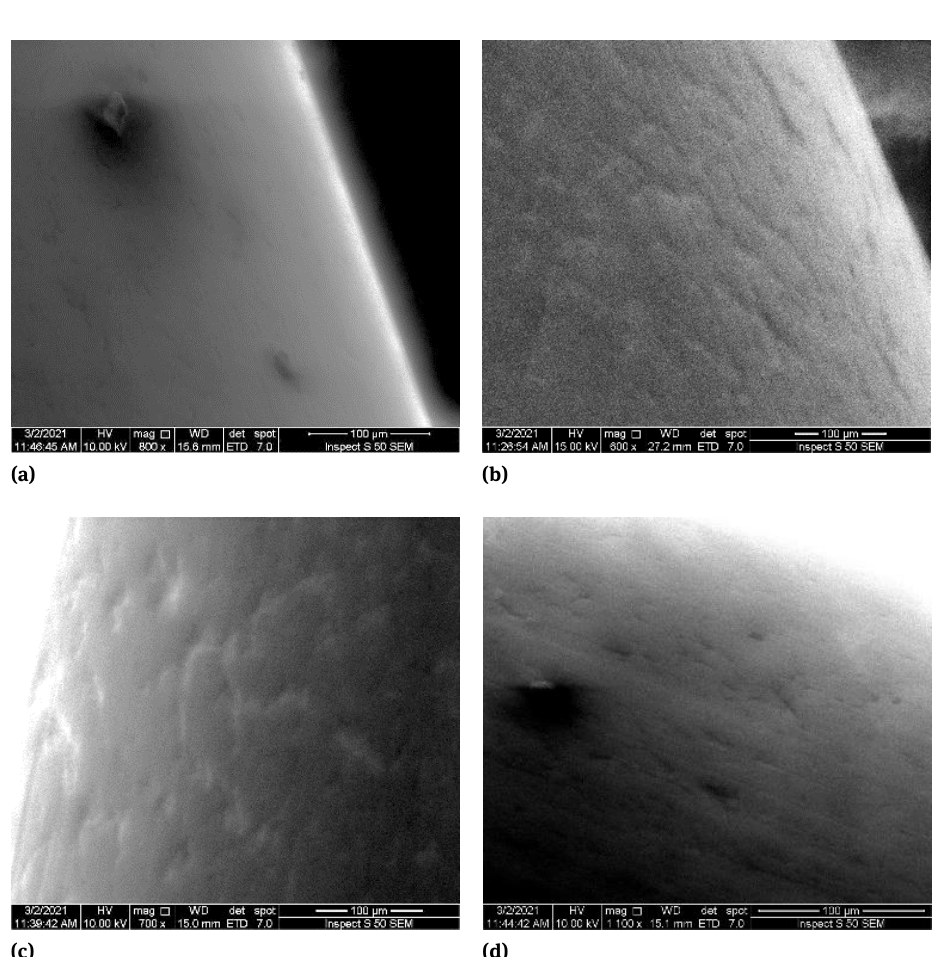
Figure 2: SEM images of (a) Untreated SS316L wire surface, (b) scratched SS316L wire for 60min, (c) scratched SS316L wire for 90min and (d) scratched SS316L wire for